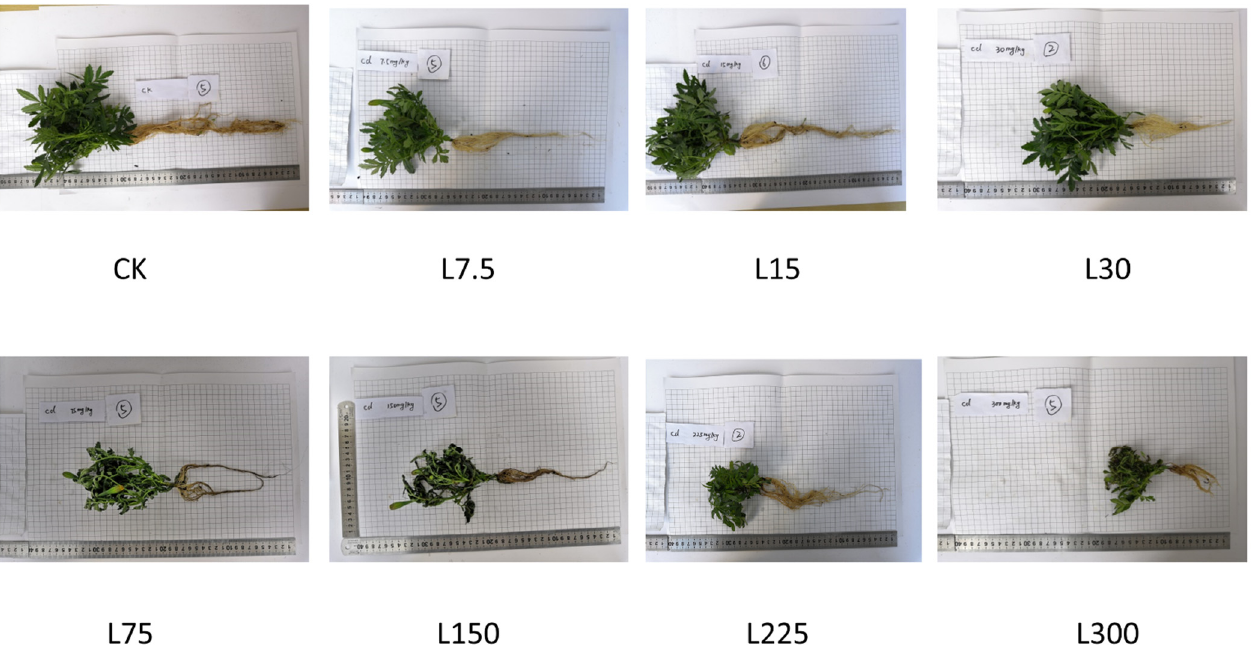
Figure 1. Tagetes patula performance under different concentrations of Cd treatment on day 30.